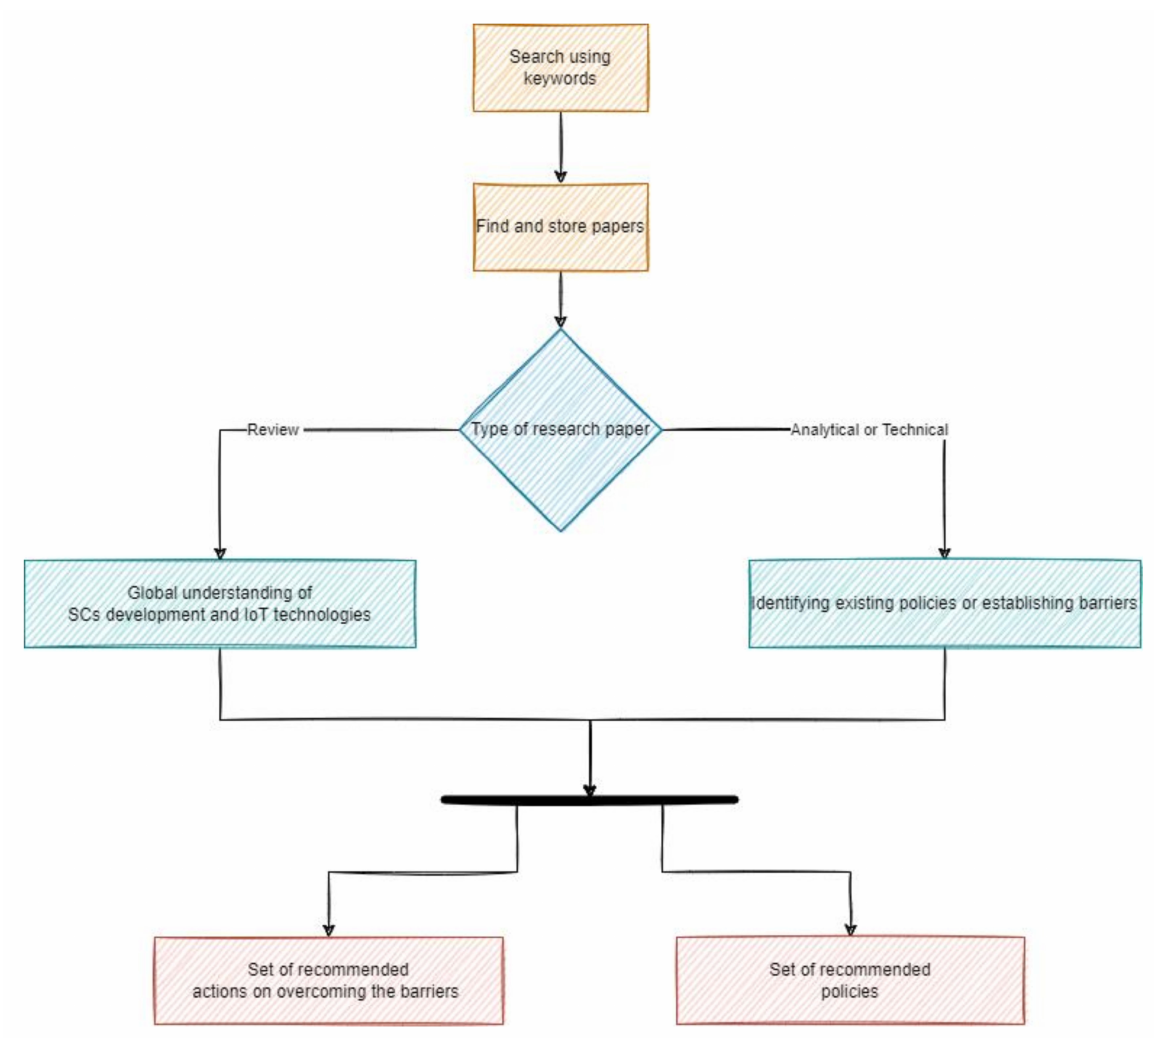
Figure 1. The methodology